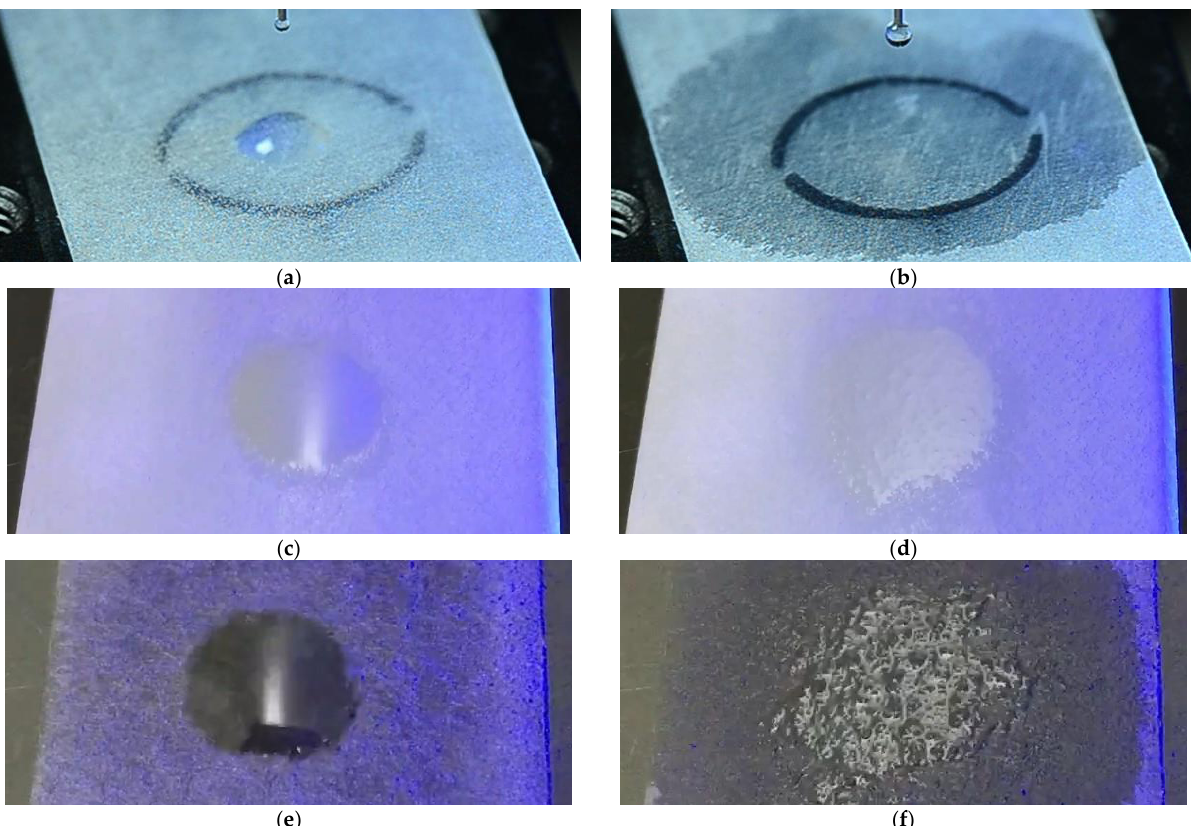
Figure 6. Snapshots for sanded films taken after being treated with APPJ at the moments that ( a ) a droplet was falling on a PP film initially; ( b ) the drop was spreading over the PP film; ( c ) a droplet was falling on a PET film initially; ( d ) the drop was spreading over the PET film; ( e ) a droplet was falling on a PE film initially; and ( f ) the drop was spreading over the PE film.